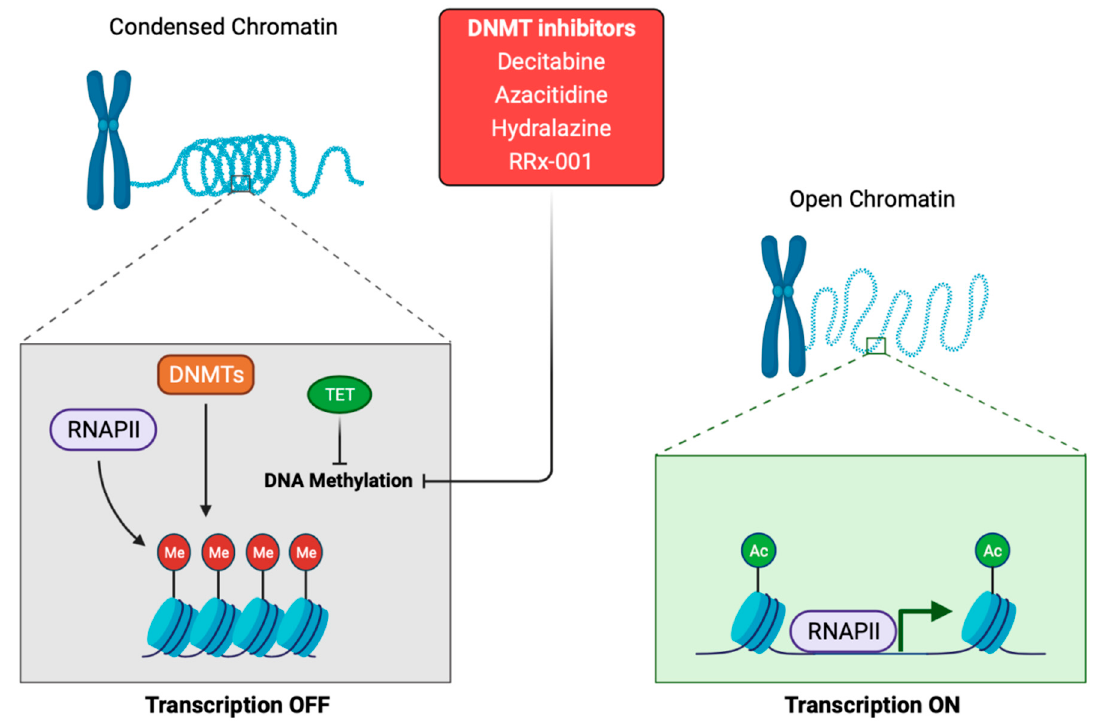
Figure 1. Schematic representation of the DNA methylation process. DNMTis inhibits DNA methylation by downregulation of DNMTs. The action of DNA methylation inhibitors (DNMTs inhibitors and TET proteins) triggers a chromatin-remodeling process and chromatin structure becomes transcriptionally accessible to RNA polymerase II, which will begin the transcription process. DNMTis: DNA methyltransferases inhibitors. DNMTs: DNA methyltransferases. TET: ten-eleven translocation proteins. RNAPII: RNA polymerase II. Me: methyl. Ac: